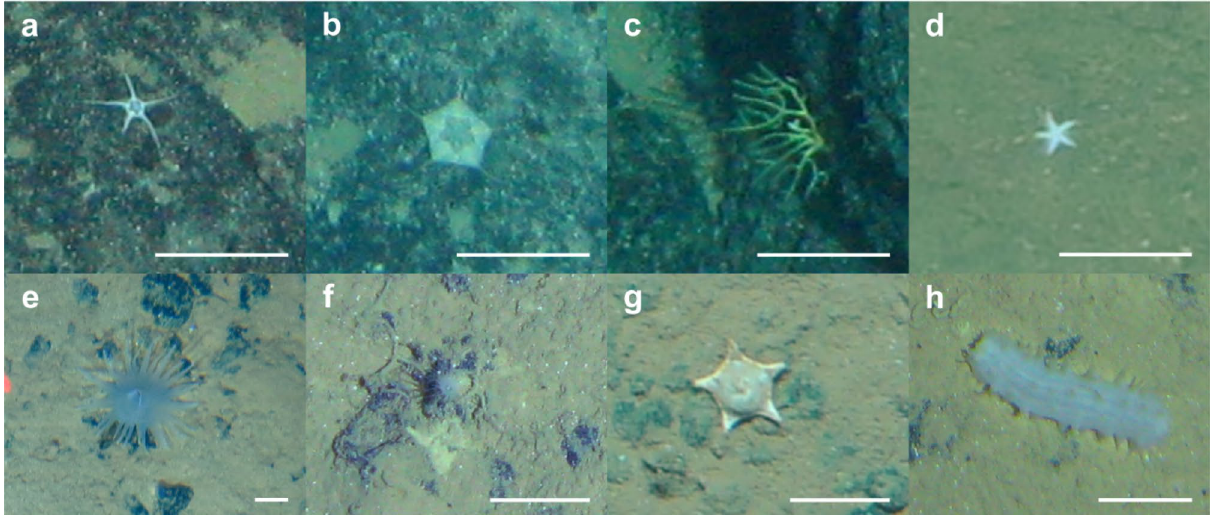
Figure 3. Images of selected morphotypes most closely associated with an assemblage: Ophiopyrgidae mtp- OPH_003 ( a ), Hymenaster sp. indet. mtp-AST_017 ( b ), Bryozoa mtp-BRY_007 ( c ), Paxillosida mtp-AST_004 ( d ), Actiniaria mtp-ACT_004 ( e ), Ceriantharia mtp-CER_008 ( f ), Hyphalaster sp. indet. mtp-AST_007 ( g ), Synallactes sp. indet. mtp-HOL_007 ( h ); scale bars represent 5